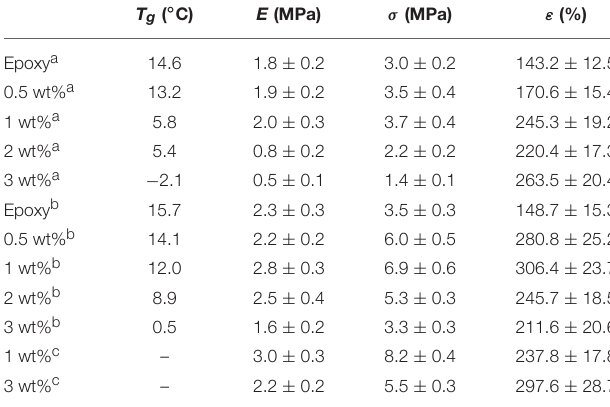
aGnP/epoxy composite, and 55.6 and 130.0% higher than epoxy. TABLE 1 | Physical properties of aGnP/epoxy and hGnP/epoxy